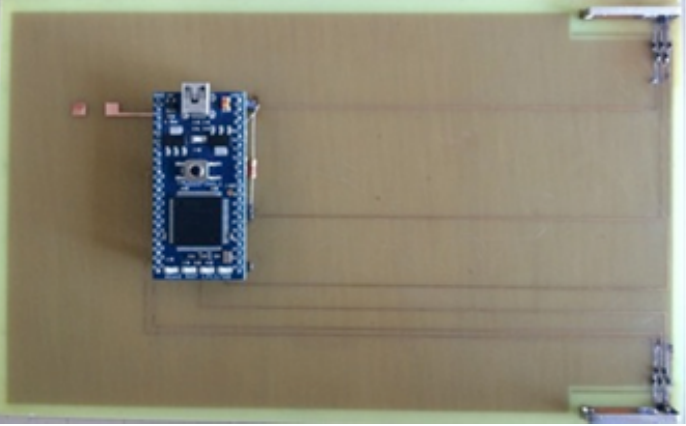
Figure 12. Top view of the proposed antenna prototype.